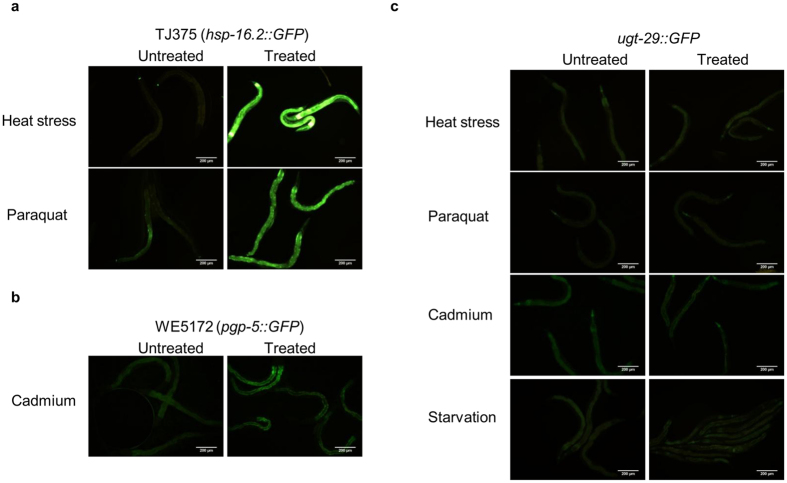
The expression of ugt-29 was not visibly induced upon challenge by environmental stressors.GFP expression was observed in (a) TJ375 worms exposed to heat stress (37 °C for 1 hour) and 10 mM paraquat; (b) WE5172 worms exposed to 100 μM cadmium and (c) ugt–29::GFP worms exposed to heat stress, paraquat, cadmium and starvation. Paraquat-treated worms were examined at 6 hours post treatment whilst for the other three stress conditions, worms were assessed at 24 hours post treatment. The exposure time and gain factor are similar for all the micrographs taken. Scale bar, 200 μm.